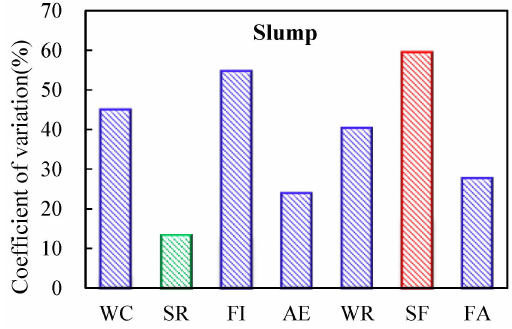
Figure 17. Difference analysis of factors on